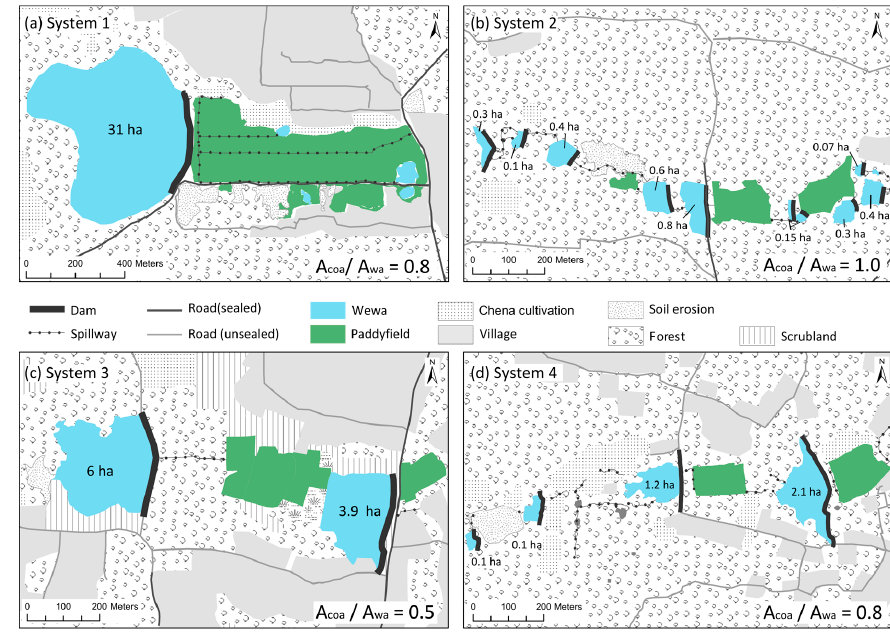
Figure 2. Sketches ( a – d ) show the layout of four tank cascade systems north of Anuradhapura ( a ) system 1; ( b ) system 2; ( c ) system 3; ( d ) system 4. (A coa : water-spread Area, A wa : water-spread area).